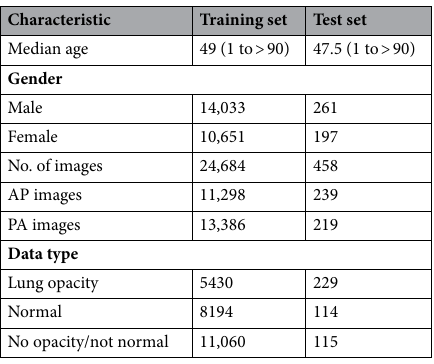
Table 1. Demographics of the training and test datasets.